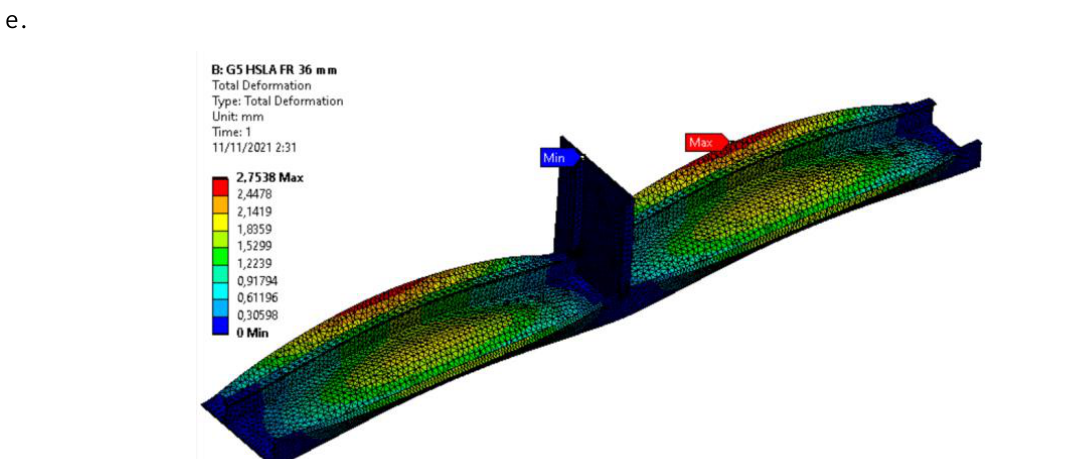
Figure 15. Total Deformation Results: a. Geometry 1: Hatch Coaming Model [16]; b. Geometry 2: Perpendicular Figure 15: Total deformation results: a. Geometry 1: Hatch coaming model [16]; b. Geometry 2: Perpendicular joint [12]; c. Geometry 3: Stool Joint [12]; c. Geometry 3: Stool Joint [12]; d. Geometry 4: Bottom-Stiffened Panel [27]; e. Geometry 5: Side- joint [12]; d. Geometry 4: Bottom-stiffened panel [28]; e. Geometry 5: Side-stiffened panel Stiffened Panel [28]